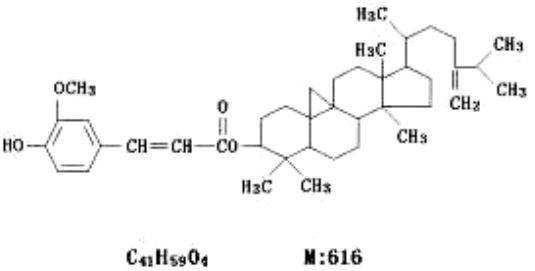
Fig. 2. Chemical structure of gamma oryzanol. 23